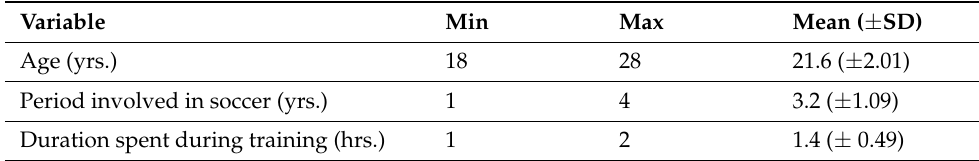
Table 3. The demographic profile of soccer athletes.